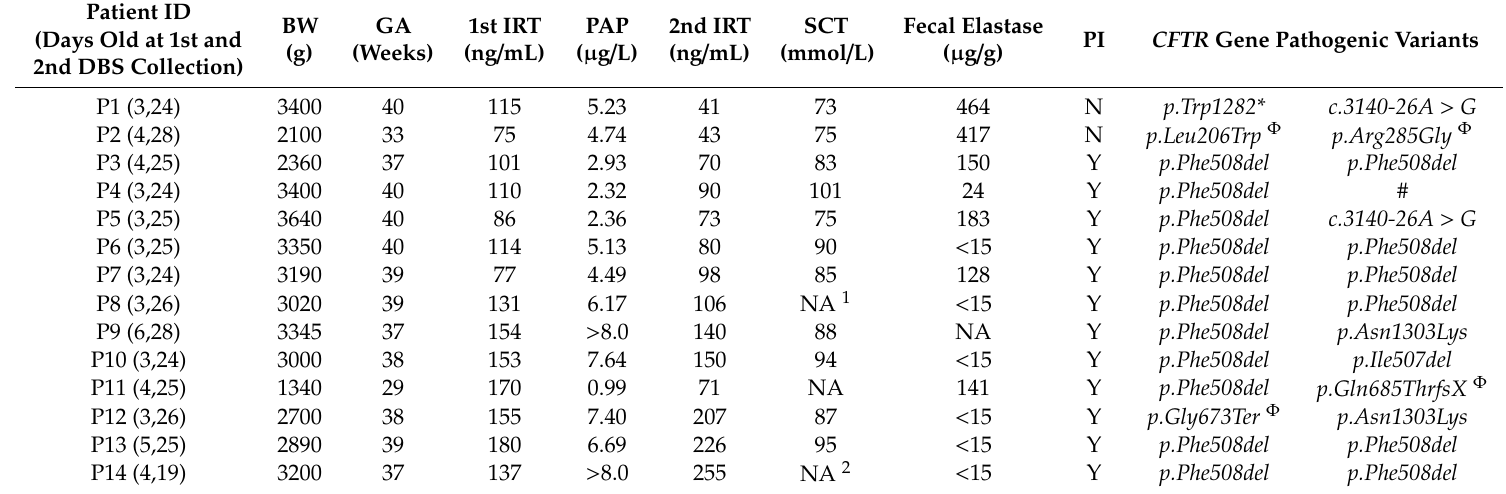
Table 1. NBS results and clinical data from CF infants identified during the CF-NBS pilot